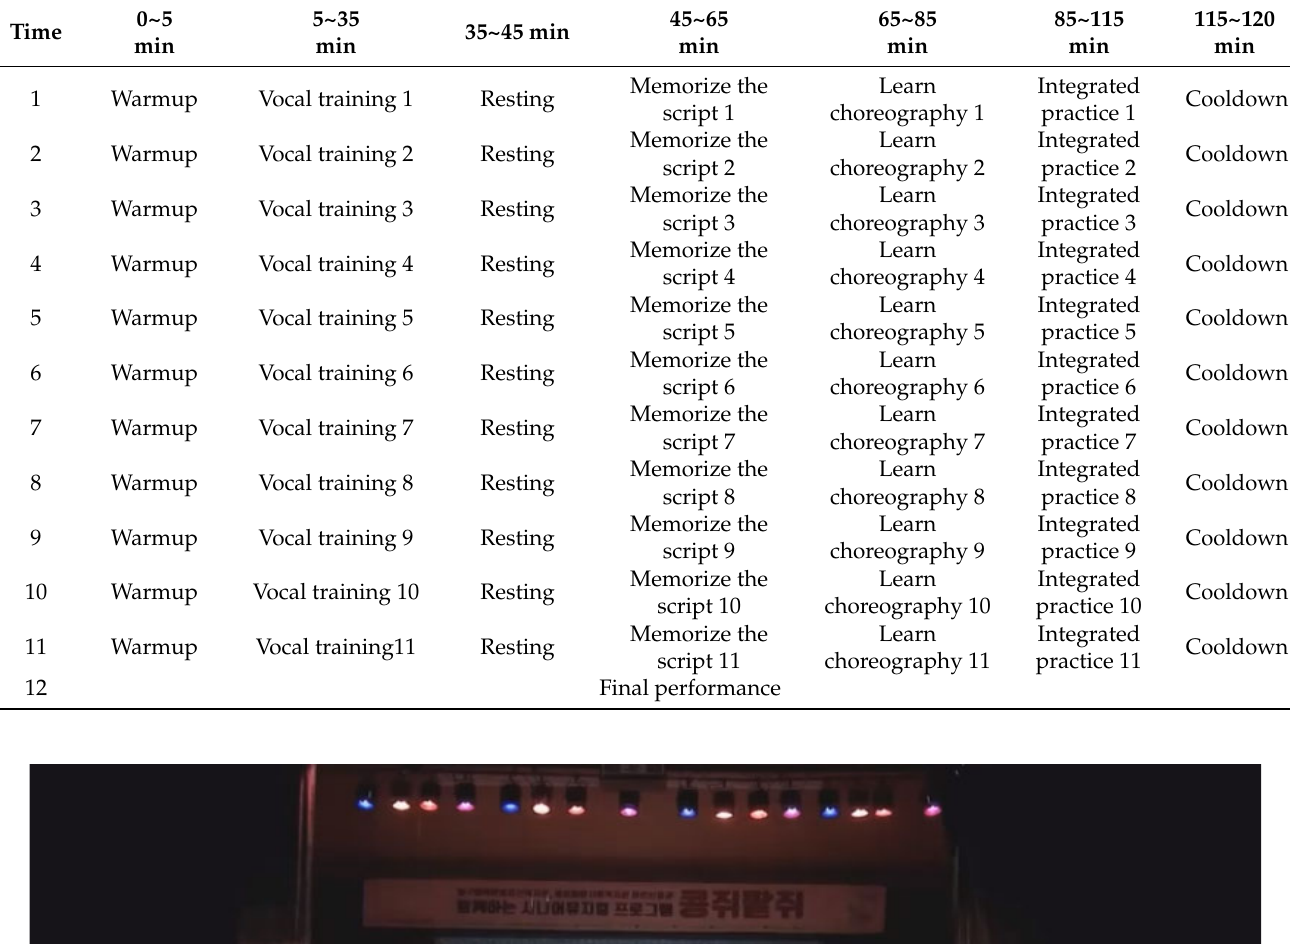
Table 2. Senior musical program.